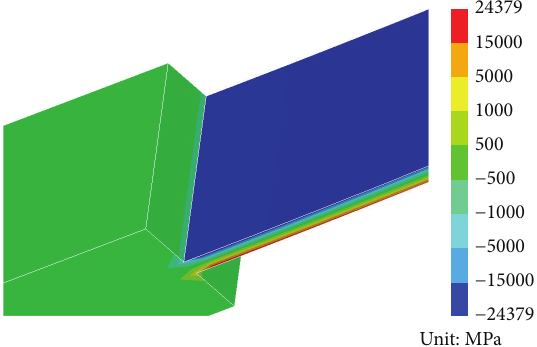
Figure 10: Stress fringes for 𝜎 𝑥 in the step